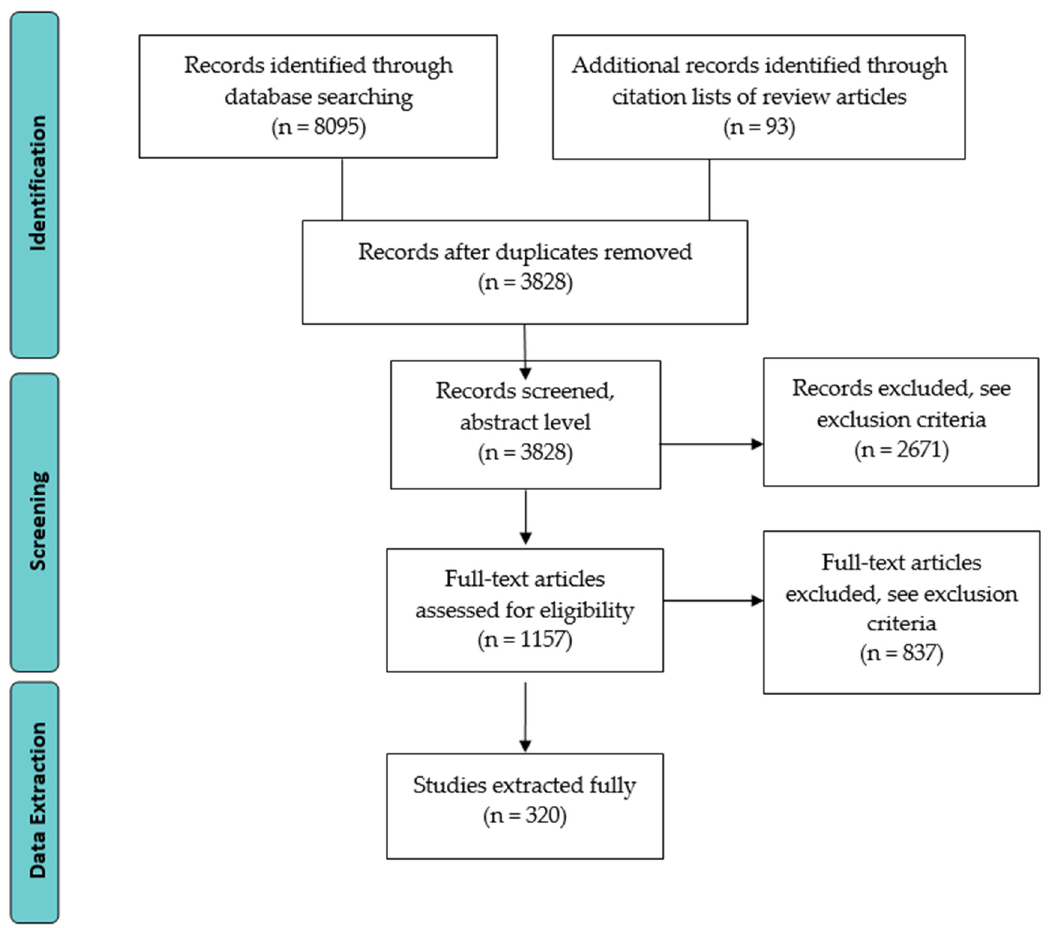
Figure 1. PRISMA Diagram for this scoping review.